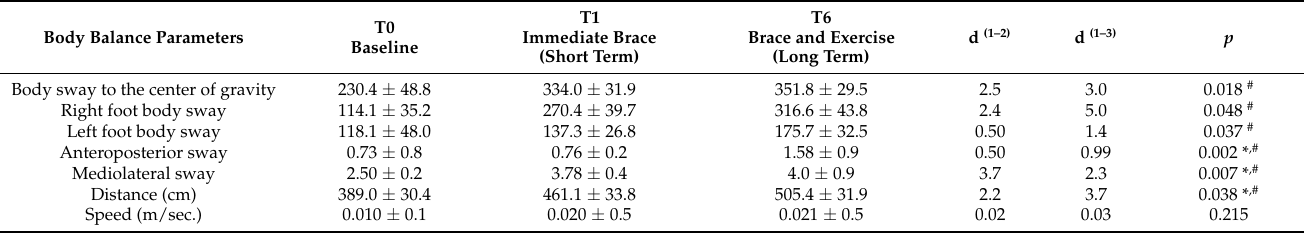
Table 8. Comparisons of body balance between the different moments: T0—baseline, T1—after immediate use of the spinal orthopedic brace (short term, 24 h) and T6 after six months using the brace associated with specific exercises (long term) in adolescents with idiopathic